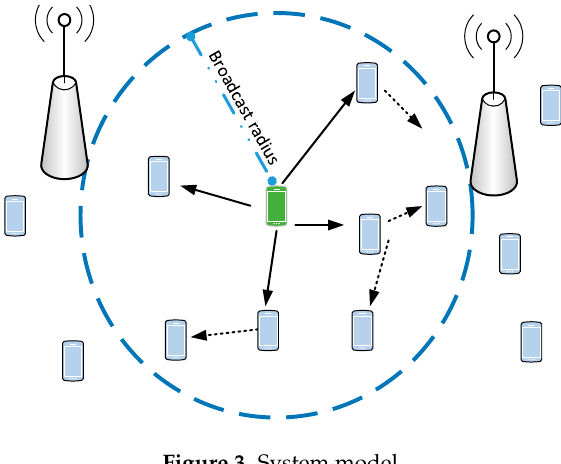
Figure 3. System model.